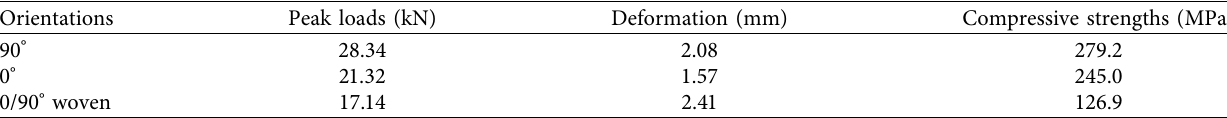
Figure 16: Diferent fber orientation and compression test results. Table 3: Results of the compression properties of fber-oriented 90 ° , 0 ° , and 0/90 ° composites.